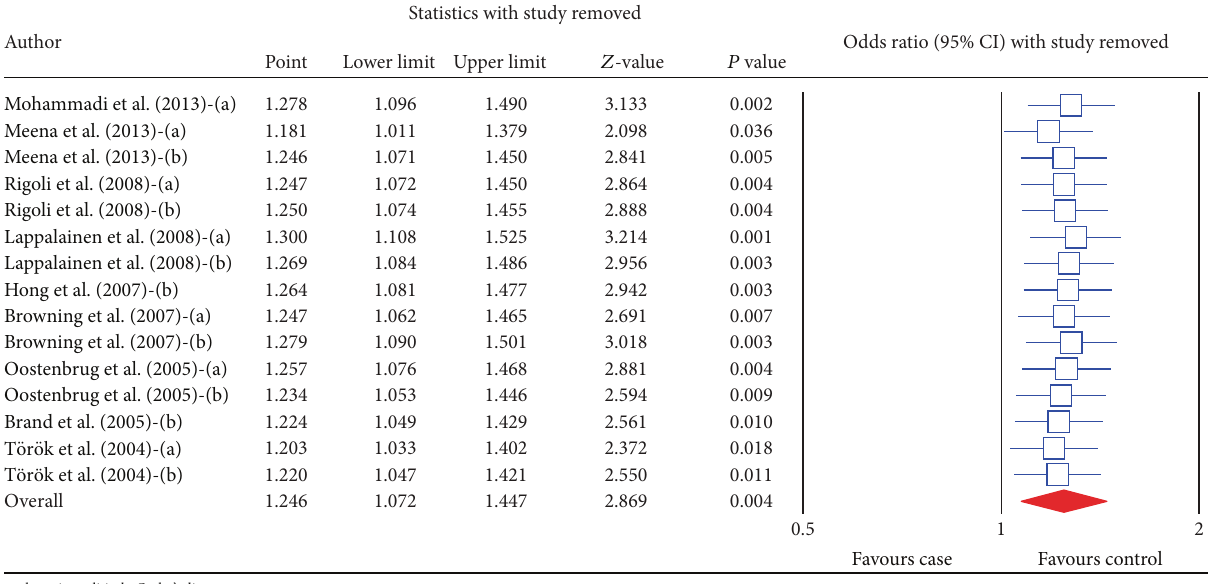
Figure 4: Sensitivity analysis of the differences in allele and genotype frequencies of TLR4 rs4986790A > G and rs4986791C > T polymorphism between case and control groups. (a) Sensitivity analysis of the differences in allele frequencies of rs4986790A > G; (b) sensitivity analysis of the differences in genotype frequencies of rs4986790A > G; (c) sensitivity analysis of the differences in allele frequencies of rs4986791C > T; (d) sensitivity analysis of the differences in genotype frequencies of rs4986791C >